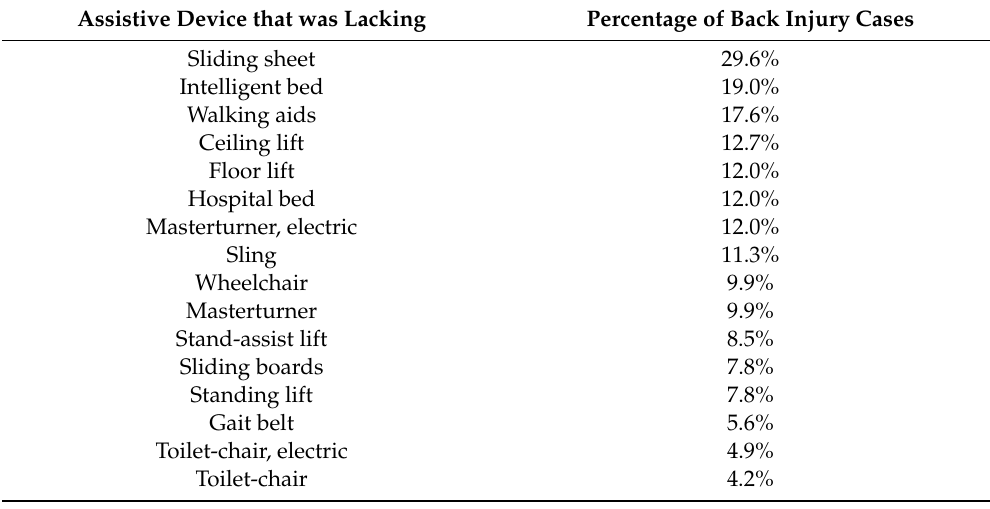
Table 3. Prevalence as percentage (%) of necessary assistive devices that were lacking in relation to back injury events among those who stated that one or more assistive devices were